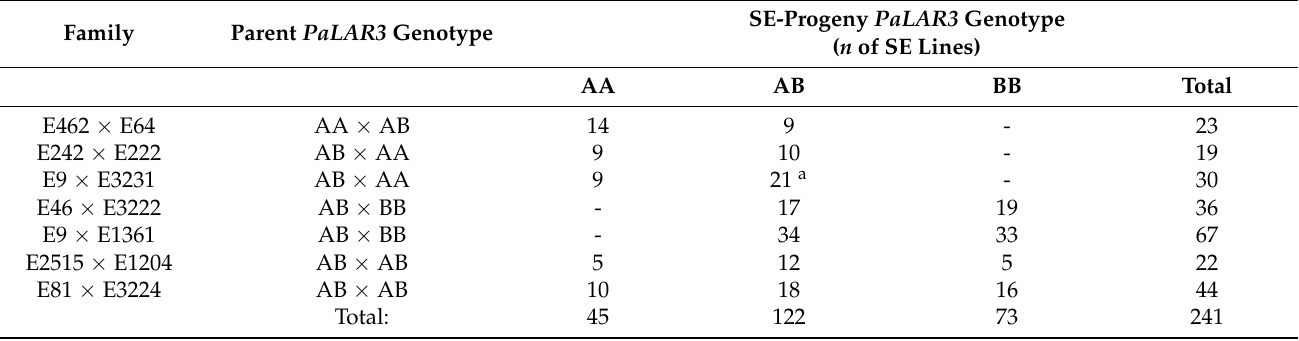
Table 2. The PaLAR3B allele delivery through the SE-pipeline in seven Finnish elite tree SE-families. Family Parent PaLAR3